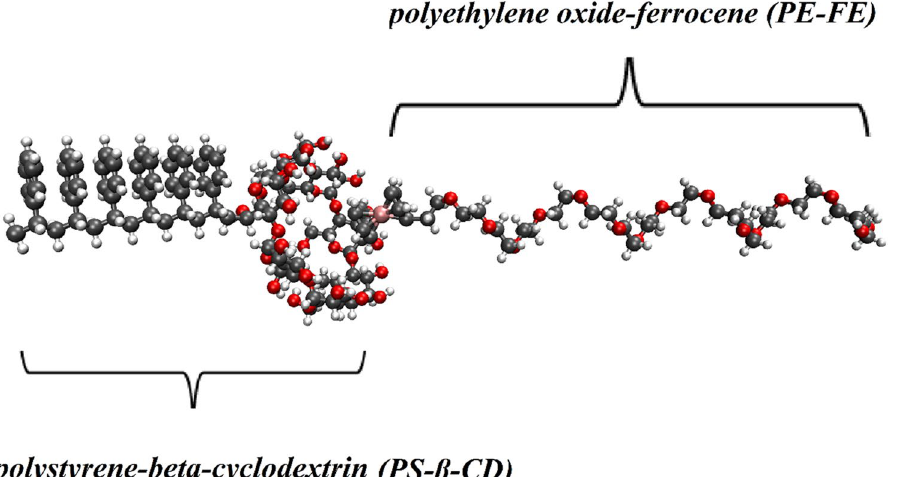
Figure 1. Structure of PS-β-CD and PE-FE molecules.